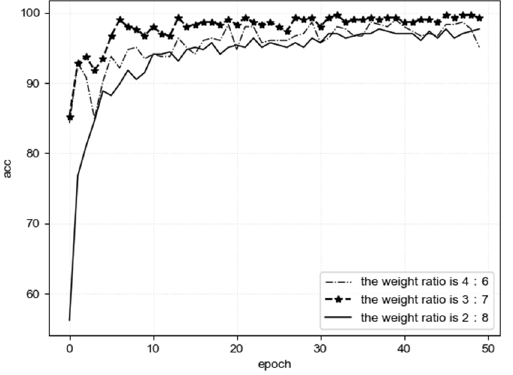
Table 2. Loss and accuracy of AlexNet and optimized AleNet.